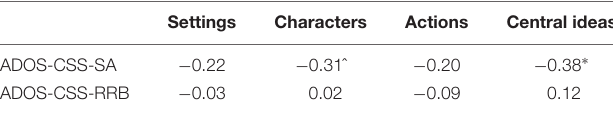
TABLE 4 | Comparison of percentages of participants in the ASD and TD groups who included different ranges of central ideas in their narratives. Ranges of central ideas ASD TABLE 5 | Pearson correlations of semantic-pragmatic items with autism severity measures (ADOS-CSS-SA,